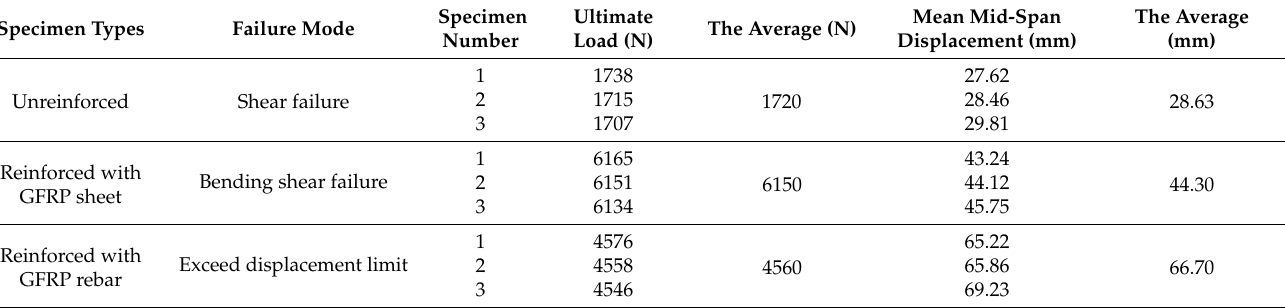
Table 1. Static load test results of three-point bending for